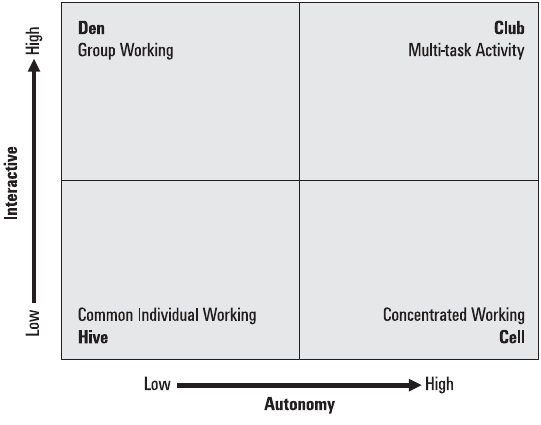
Figure 2. Work patterns and space model Adapted from: Laing et al.